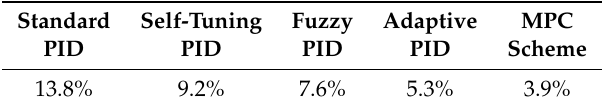
Table 5. Sensitivity analysis applied to the wind turbine benchmark.